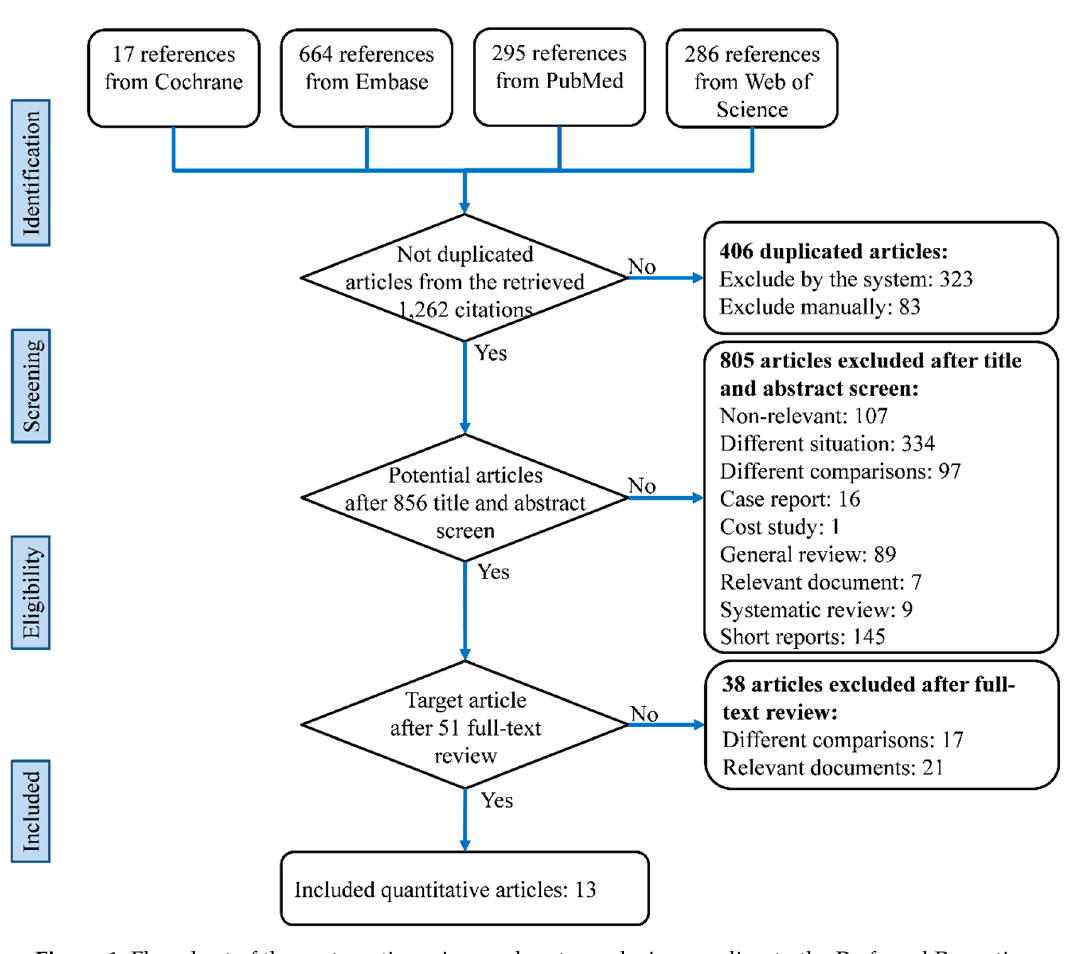
Figure 2. Network plot of sustained virologic response at post-treatment week 12 among patients with different renal conditions. RR, risk ratios; CKD, chronic kidney disease.